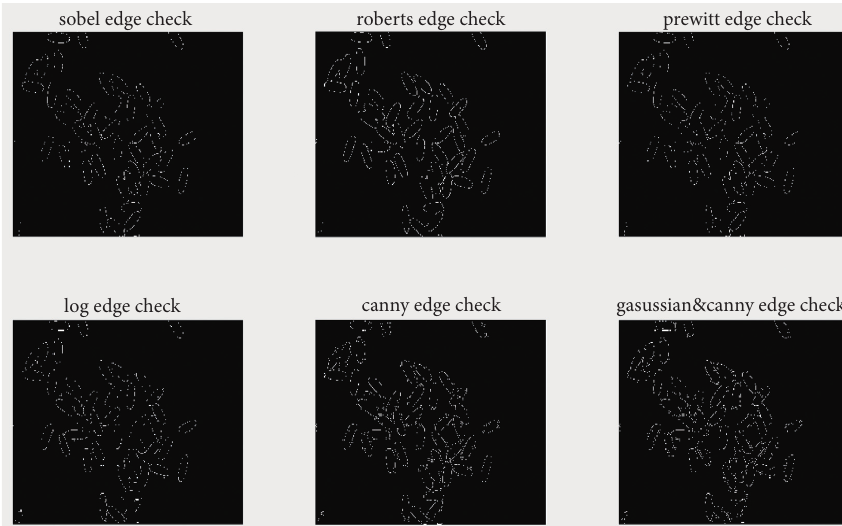
Figure 25: The edge detection algorithm with different operators.